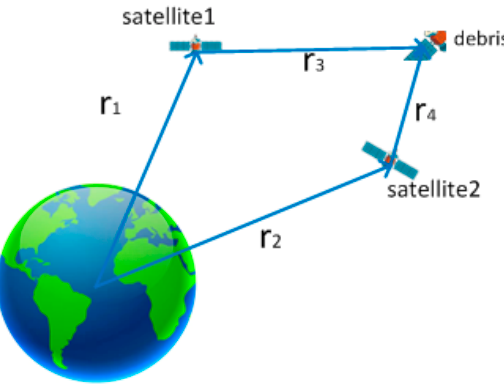
Figure 11. Multiple star trackers observation schematics.